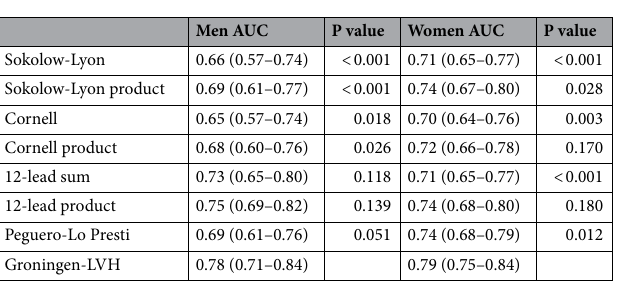
Table 3. AUCs of the new developed criteria versus AUCs of existing criteria in the training cohort. AUC area under the curve, LVH left ventricular